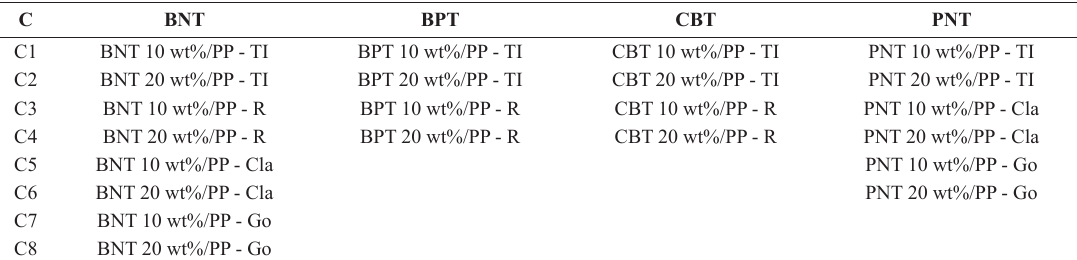
Table 1. Experimental conditions studied per group.